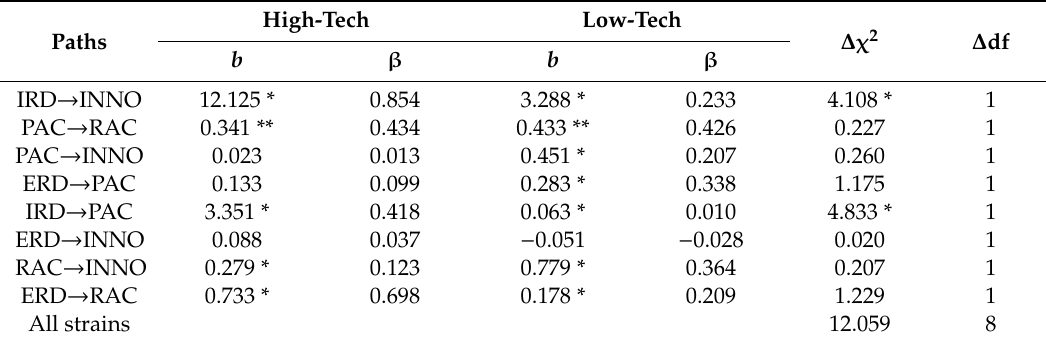
Table 12. Result of multi-group comparison.